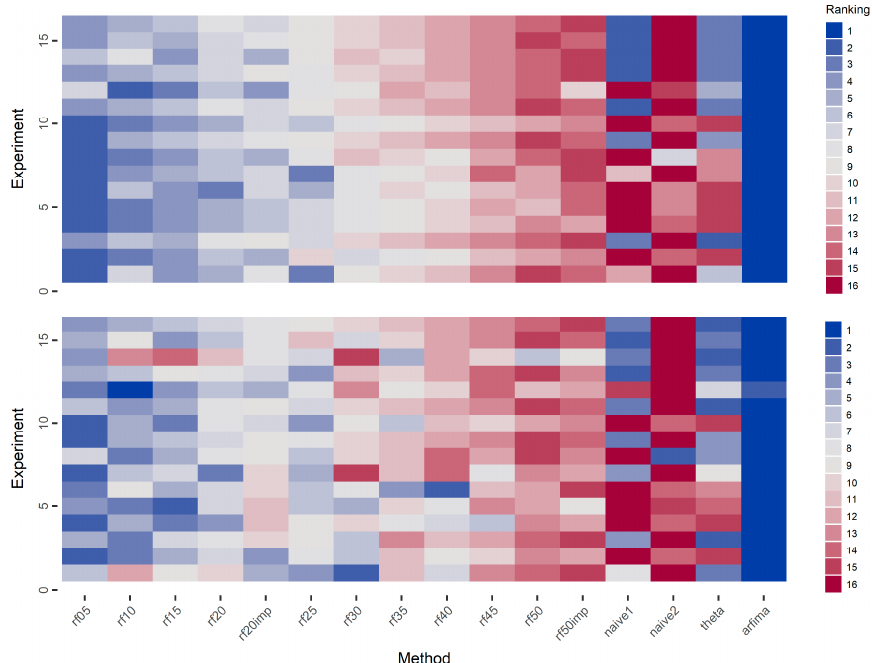
Figure 10. Ranking of methods within each simulation experiment based on the mean ( top ) and median ( bottom ) of the absolute errors. Better methods are presented with lower ranking value and blue colours.